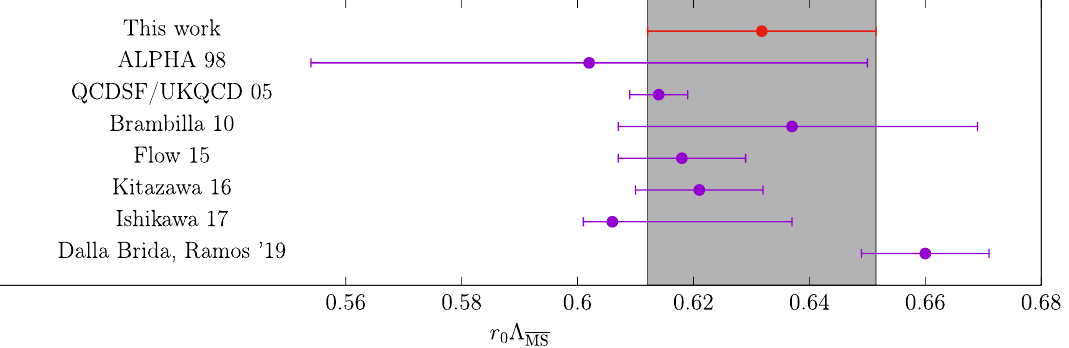
Fig. 6 Final result for r 0 (cid:2) compared with the values included in the FLAG average [61]. These are: ALPHA 98 [62], QCDSF/UKQCD 05 [63], MS Brambilla [64], Flow 15 [65], Kitazawa 16 [66], Ishikawa 17 [12]. We also include the recent work Dalla Brida, Ramos 19 [13] in the comparison Fig. 7 Topological charge vs Monte Carlo time for, from top to bottom, ˜ L = 48, 36 and 24, corresponding to an approximately fixed physical size of ˜ l ∼ 1 . 1